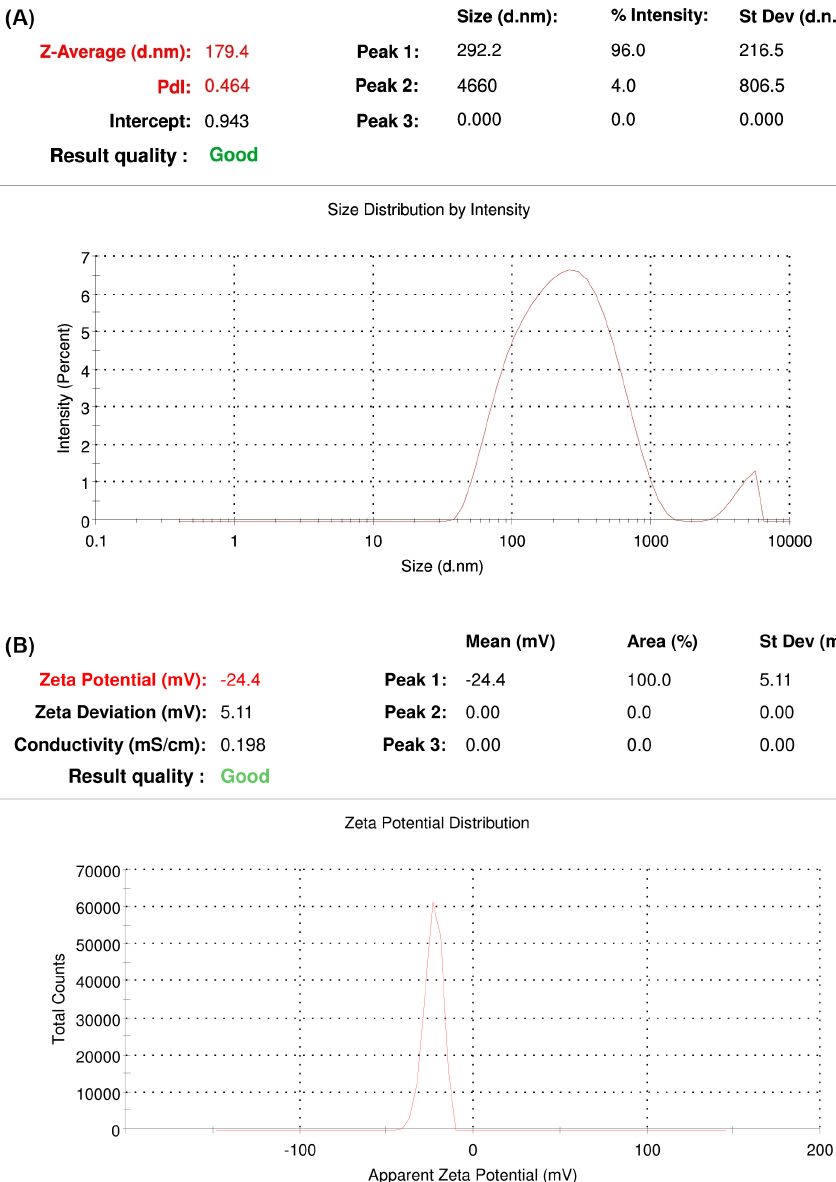
FIGURE 3 - (a) Particle Size; (b) Zeta potential of